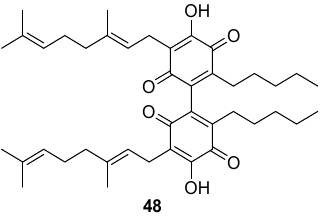
Figure 6. Structure of cannabigerol quinoid dimer ( 48 ).